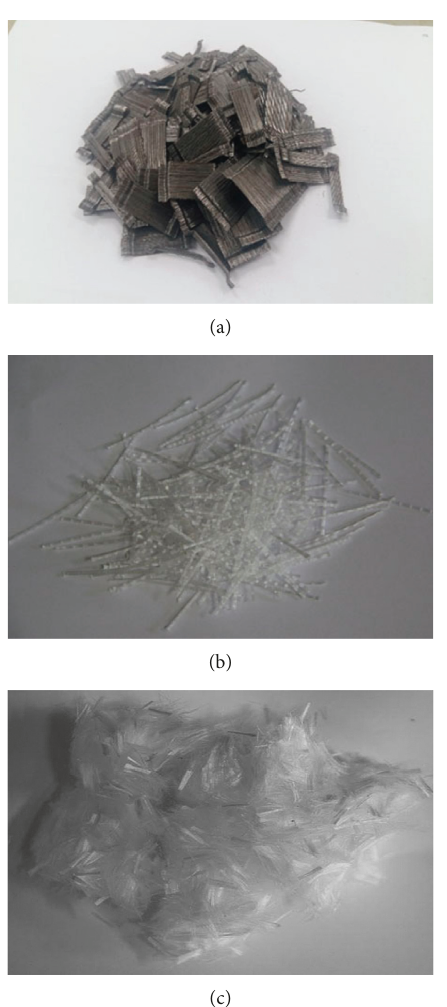
Figure 3: Geometry of reinforcing fibers. (a) Bundled end- hook-type steel fibers. (b) Macrosynthetic fibers. (c) Polypropylene